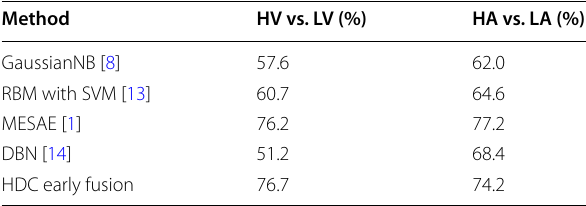
*F1 score. Accuracy value not available Table 2 DEAP classification accuracy comparison